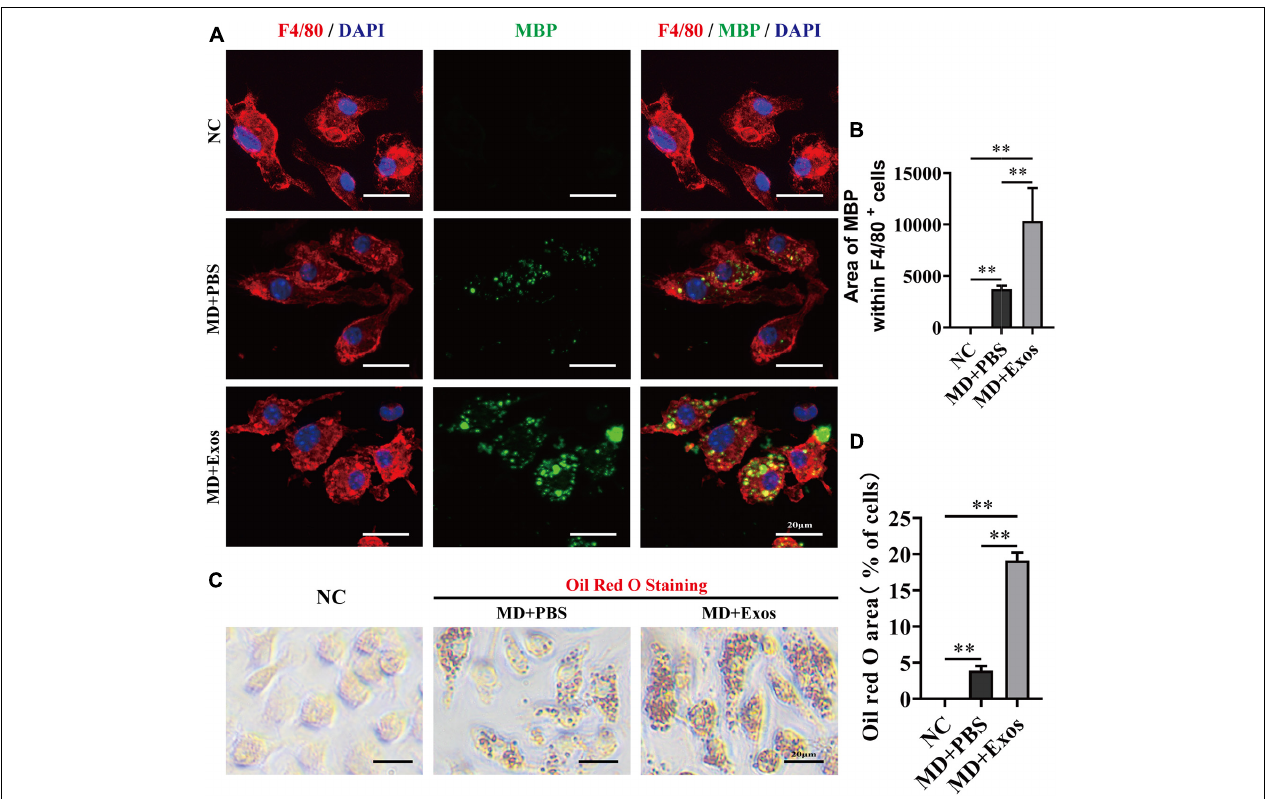
FIGURE 6 | Bone marrow mesenchymal stem cell-derived exosomes (BMSC-Exos) promoted macrophage phagocytosis of myelin debris in vitro . (A) Representative immunofluorescence images of myelin debris [myelin basic protein (MBP), green] uptake by macrophages (F4/80, red) in the NC, MD + PBS, and MD + Exos groups. Nuclei were counterstained with DAPI (blue). Scale bar = 20 µ m. (B) Immunofluorescence semiquantification of the area of MBP within the F4/80+ macrophages ( n = 3 per group, values are the mean ± SD, ∗∗ p < 0.01, one-way ANOVA). (C) Oil Red O staining of myelin debris uptake by macrophage from the NC, MD + PBS, and MD + Exos groups. Scale bars = 20 µ m. (D) Quantification of Oil red O area with all cells in (C) ( n = 3 per group; values are the mean ± SD, ∗∗ p < 0.01, one-way ANOVA). MD, myelin debris; NC, negative control without added MD and Exos; PBS, phosphate-buffered